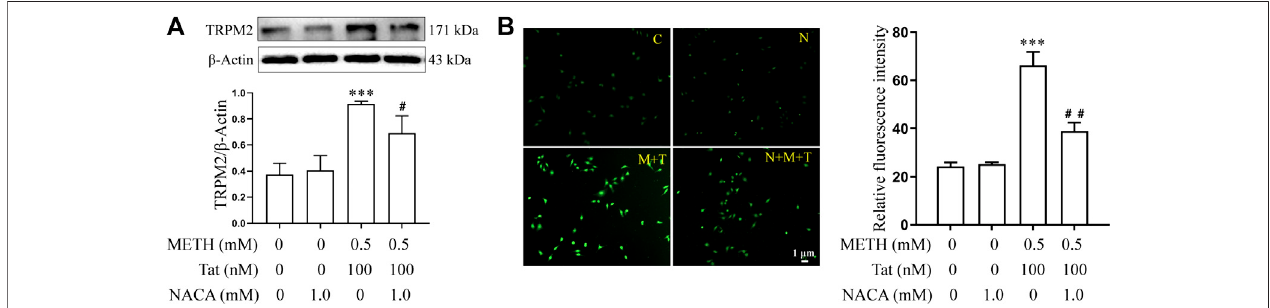
FIGURE 7 | NACA attenuates activation of TRPM2 channel synergistically induced by METH and HIV-Tat. The hCMEC/D3 cells were treated with or without 1.0 mM of NACA for 1 h before 0.5 mM of METH and 100 nM of HIV-Tat for 24 h. (A) Western blot was performed to determine the TRPM2 expression level; (B) Ca 2+ fl uorescence was observed using an inverted fl uorescence microscope (Scale bar: 1 µm), and fl uorescence intensity was analyzed using Image J software. Compared with the control, *** p < 0.001; compared with the METH + HIV-Tat, # p < 0.05, ## p < 0.01, n (cid:1) 3. C (cid:1) Control, N (cid:1) 1.0 mM of NACA, M + T (cid:1) 0.5 mM